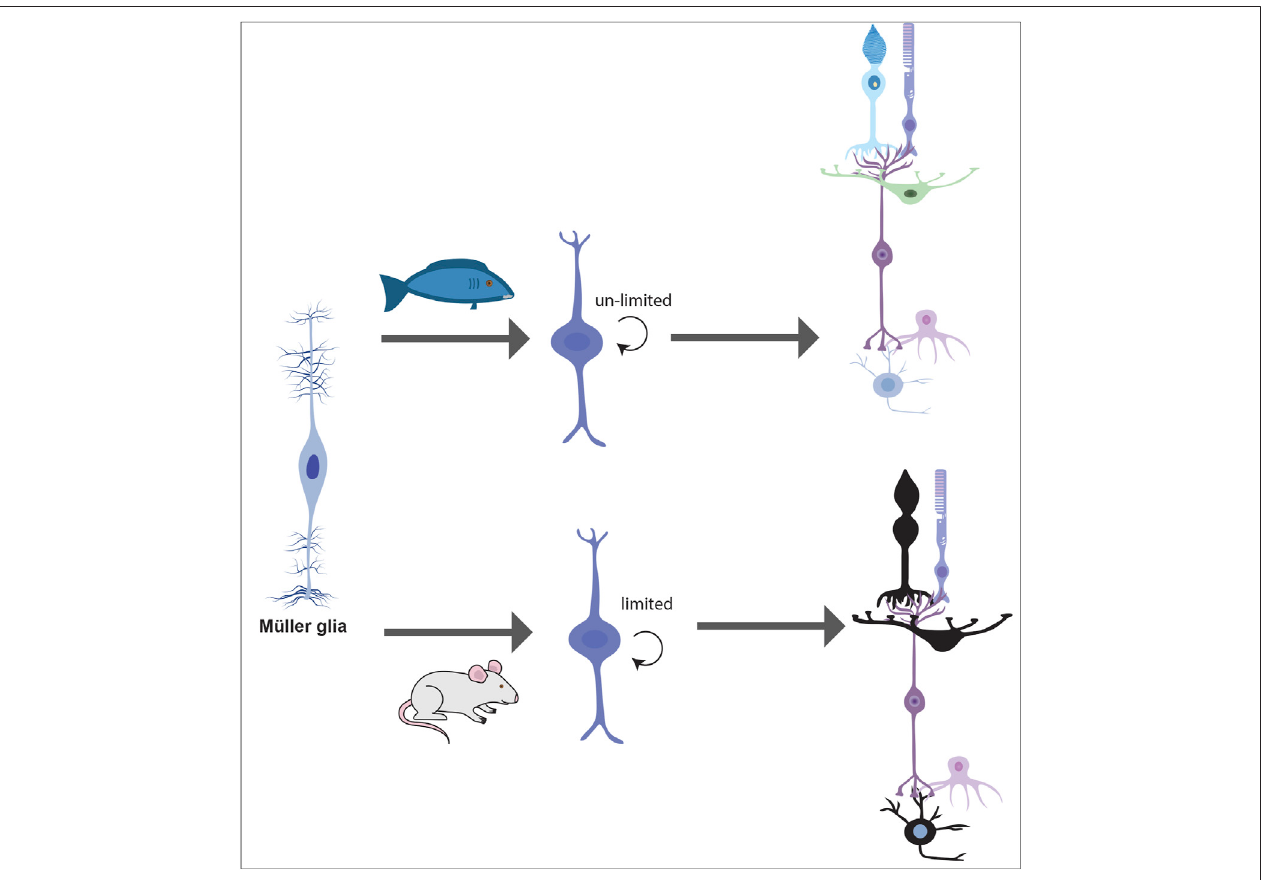
FIGURE 11 | Müller glia regeneration in fi sh versus mice. In regenerative species such as teleost fi sh, Müller glia de-differentiate into Müller glial progenitor cells (MGPCs) that have an unlimited capacity to divide. These MGPCs can give rise to all seven mature cell types in the retina. In non-regenerative species such as rodents, Müller gliahave averylimited capacity todivide, and when they are stimulated togive riseto newcells (by injury, growth factors and Ascl1),they give riseto only alimited number of mature retinal cell types. This “ mammalian regenerative ” capacity is very limited.